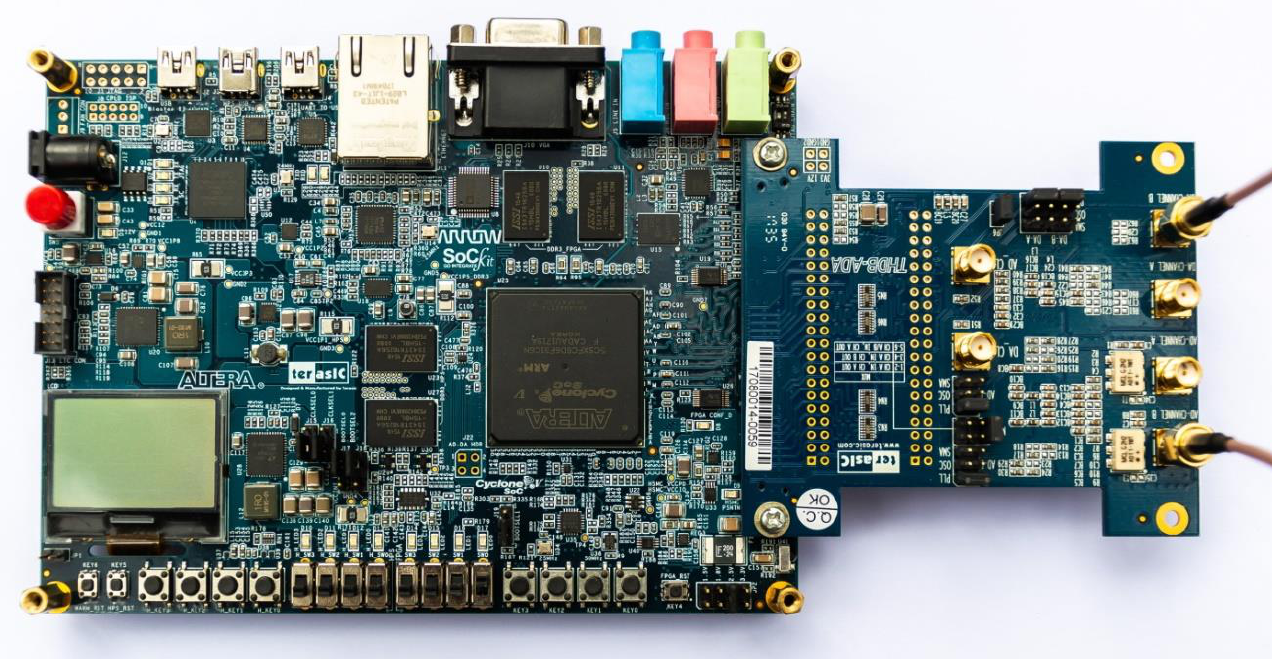
Figure 18. Communication system FPGA prototype setup on an Arrow SoCKit development board with a Terasic THDB-ADA daughter board and a coaxial cable for analog signal transmission.